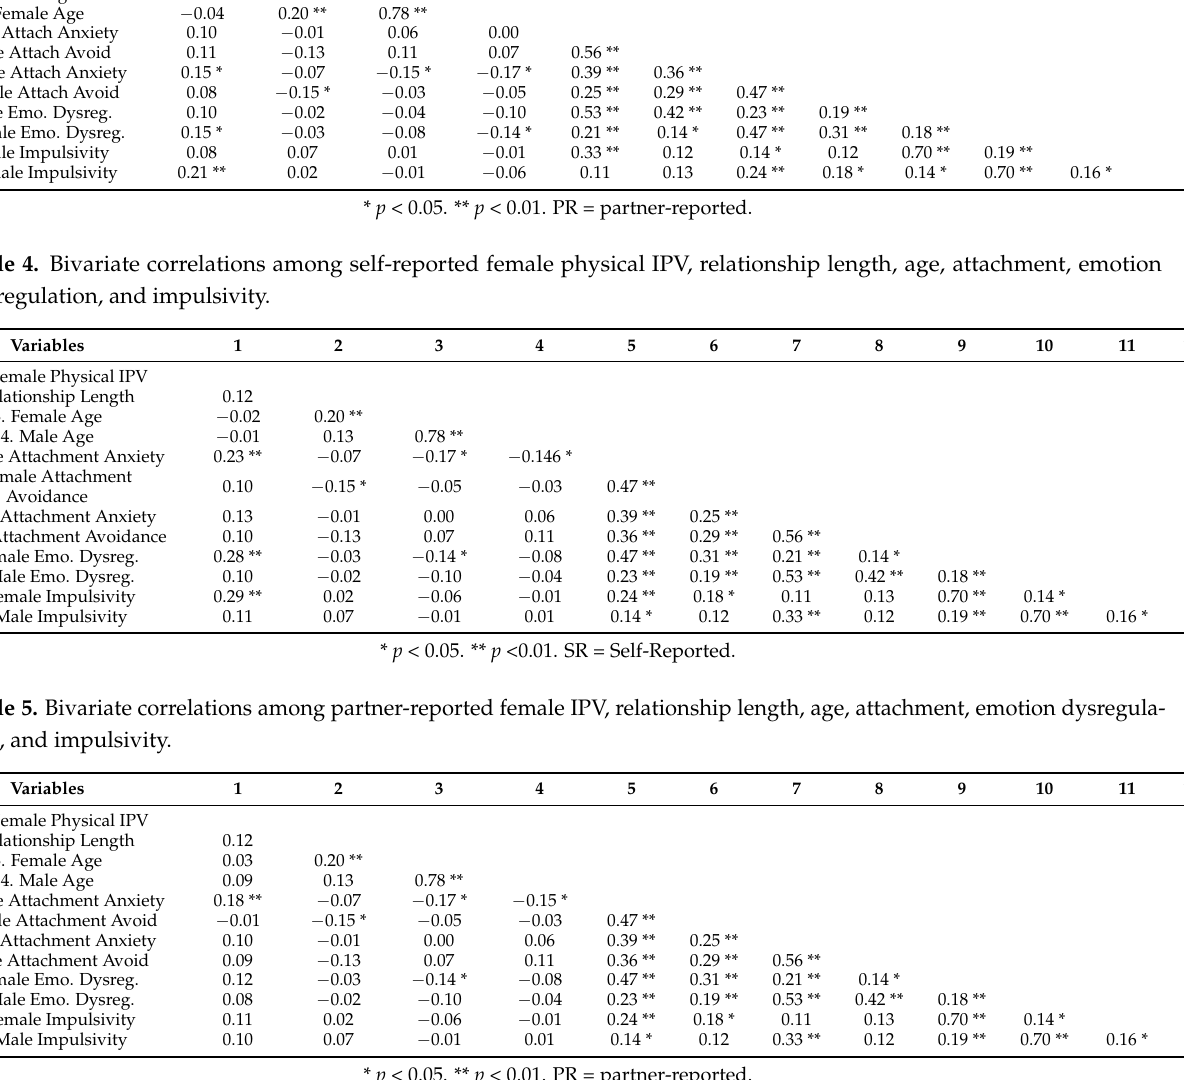
1. PR Male IPV 2. Relationship Length